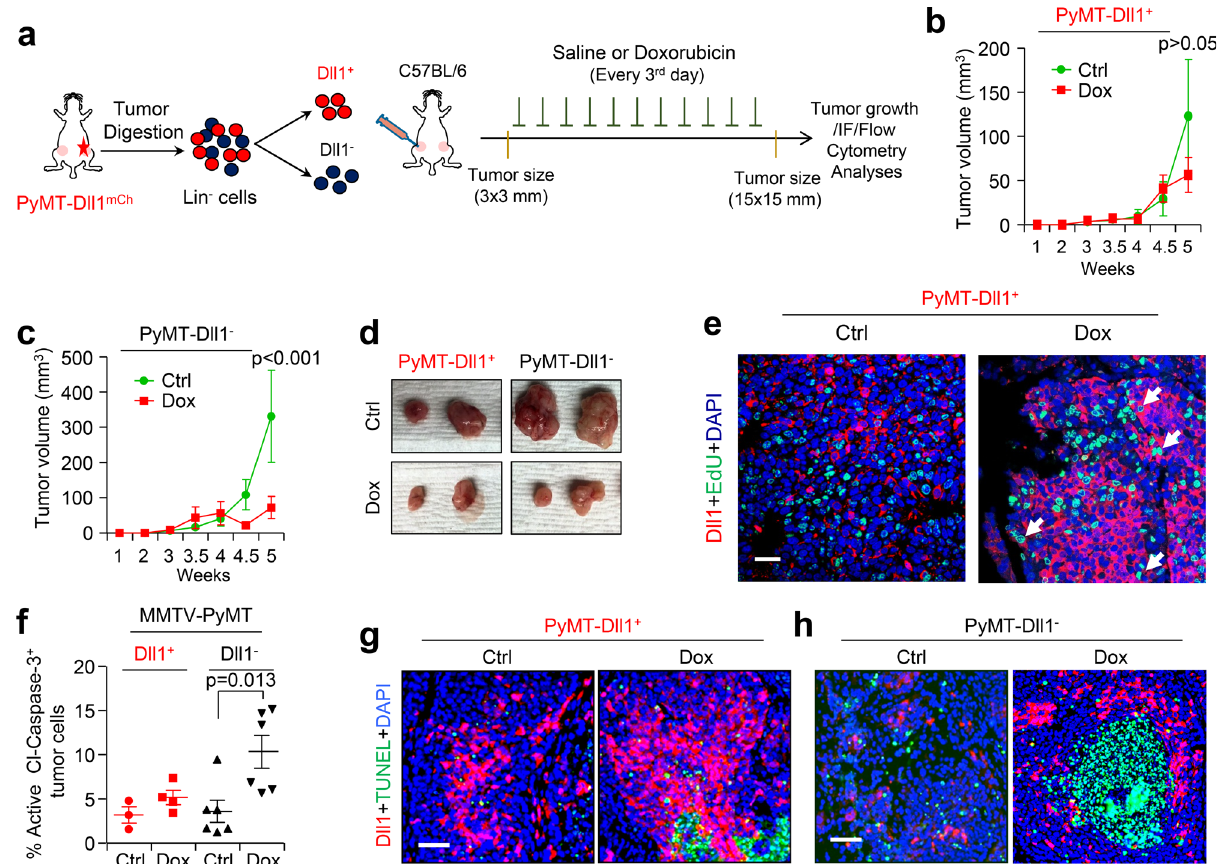
Fig. 5 Dll1 + tumor cells are chemoresistant in PyMT tumors. a Schematic shows the experimental plan of in vivo doxorubicin sensitivity assays using PyMT-Dll1 + and PyMT-Dll1 − tumors. b, c Tumor growth curves show PyMT-Dll1 + b and PyMT-Dll1 − c tumor growths upon saline (ctrl) or doxorubicin treatments. d Representative whole tumor images from b , c . b – d n = 6 tumors/group. e The representative IF images show the expression of Dll1 (Red) and EdU + proliferating cells (Green) in PyMT-Dll1 + tumors upon treatment of saline or doxorubicin. mCherry antibody was used to detect Dll1 mCh + cells. The white arrows indicate proliferating Dll1 + EdU + tumor cells upon doxorubicin treatment. f The fl ow cytometry data demonstrate the percentage of active cleaved-caspase-3 positive cells in PyMT-Dll1 + and PyMT-Dll1 − tumors treated with either saline (ctrl) or doxorubicin. g , h The representative IF images show the expression of Dll1 (Red) and TUNEL + apoptotic cells (Green) in PyMT-Dll1 + g and PyMT-Dll1 − h tumors upon treatment of saline or doxorubicin. The formalin- fi xed tumors specimen were stained with the mCherry antibody to detect Dll1 + tumor cells. P values were calculated using two-way ANOVA with Bonferroni post-test adjustment b , c and one-way ANOVA with Tukey ’ s multiple-comparisons post-hoc test f . IF experiment was repeated twice using n = 3 tumors/group e and once with n = 4 tumors/group g , h . Data are presented as the mean ± SEM. Scale bars, 60 µ m e , g , h . Source data are provided as a source data fi